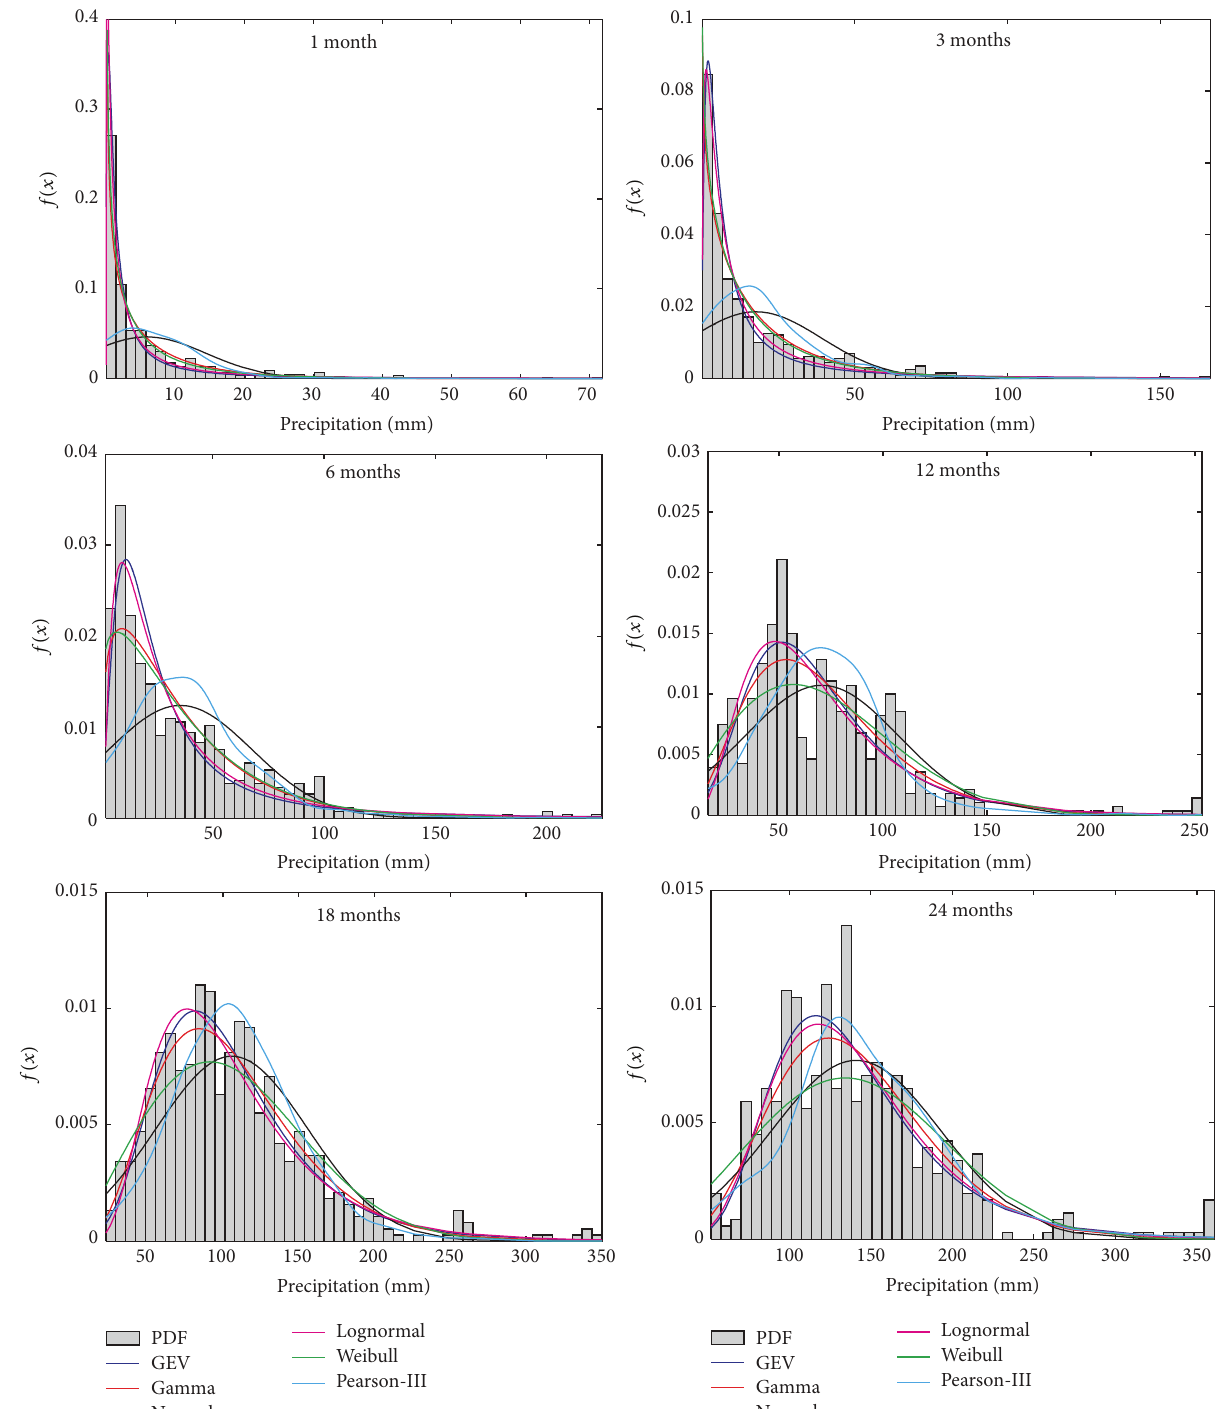
Figure 3: Empirical and modeled 𝑓(𝑥) values using the Generalized Extreme Value (GEV), Gamma, Normal, Lognormal, Weibull, and Pearson-III distributions of the water budget series at different time